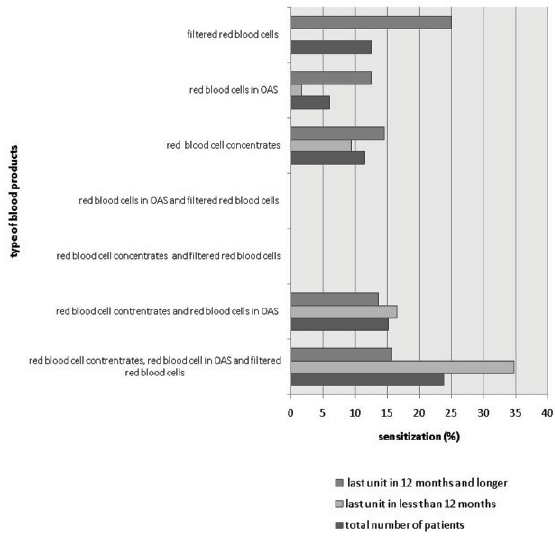
Figure 3. Correlation between the average level of sensitization and type of received blood units considering time period from last received unit until moment of testing. OAS-Optimal Additive Solution.